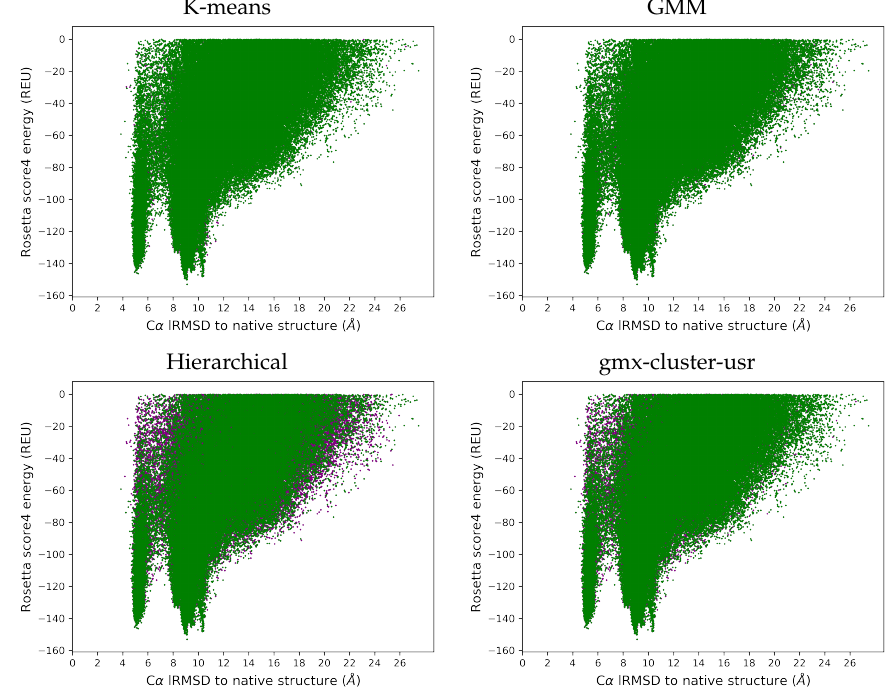
Figure 7. CASP Dataset: A representative protein (T1008-D1) is selected. Structures in the Ω gen ensemble are plotted in purple in terms of their lRMSD (Å) from the native structure (X-axis)versus their Rosetta score4 energies (Y-axis) measured in Rosetta Energy Units (REUs). Structures in the Ω red ensemble are superimposed in